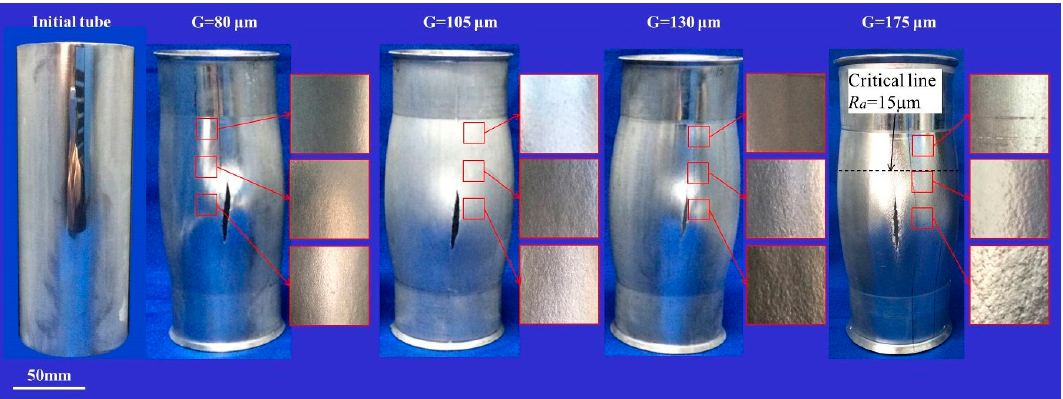
Figure 5. Bulged tubes and their respective surface roughening.